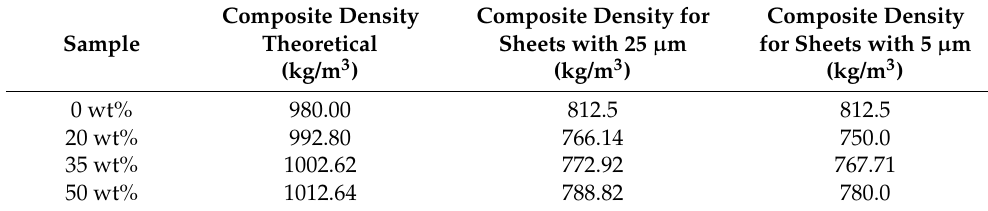
Figure 7. Composite density. Table 7. Composite density of the composite sheets.